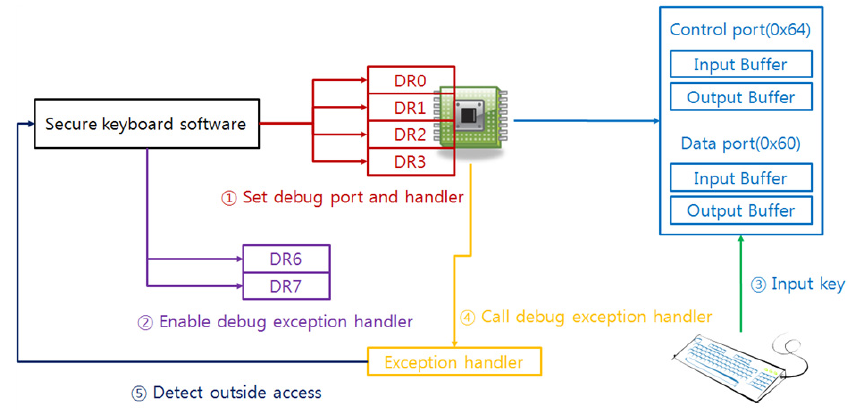
Figure 11. The countermeasure is using the exception handler of debug registers.